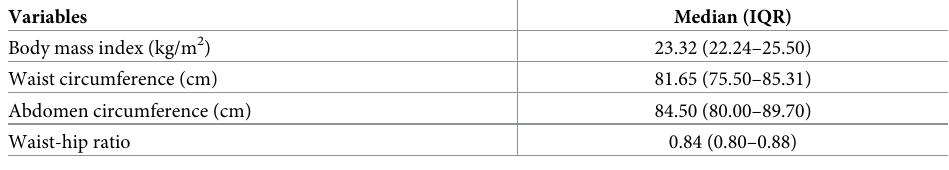
Table 3. Anthropometric measures in the study